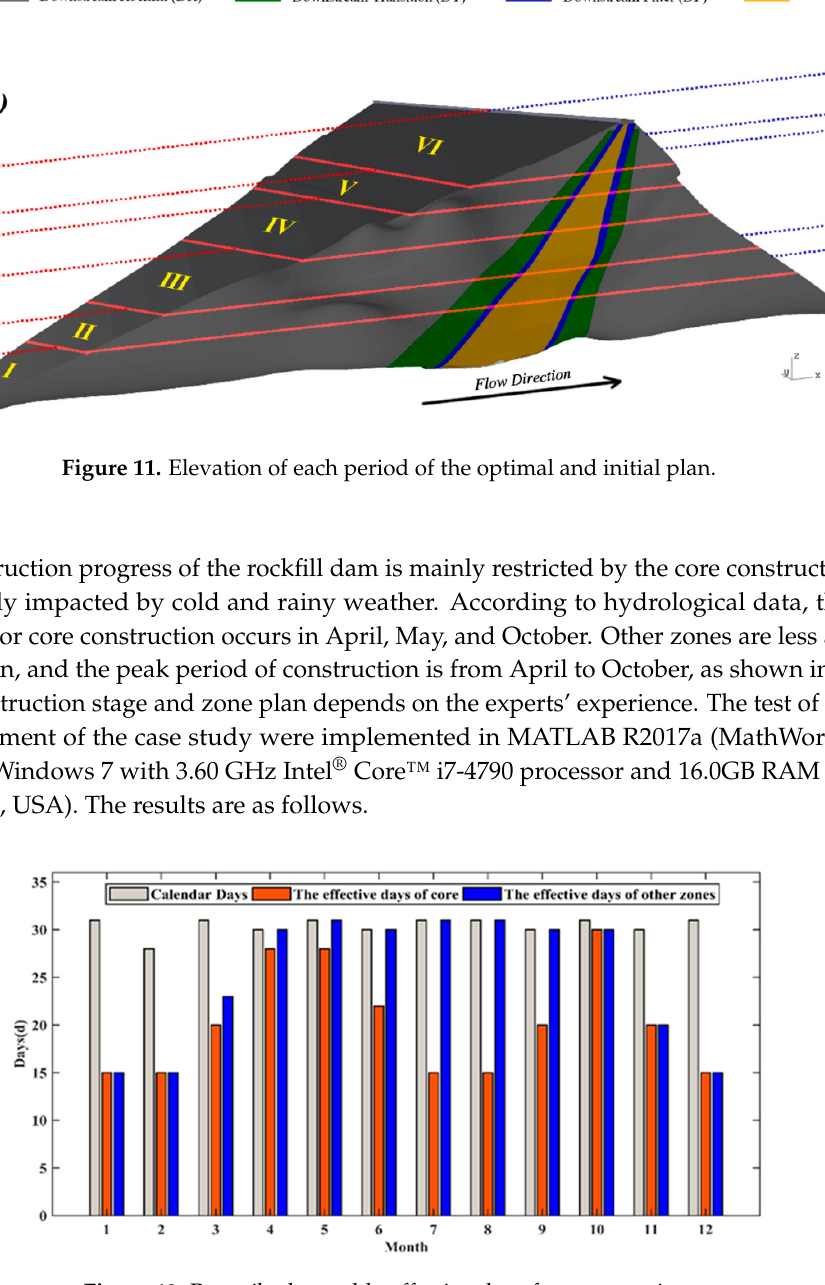
Figure 12. Prescribed monthly effective days for construction.